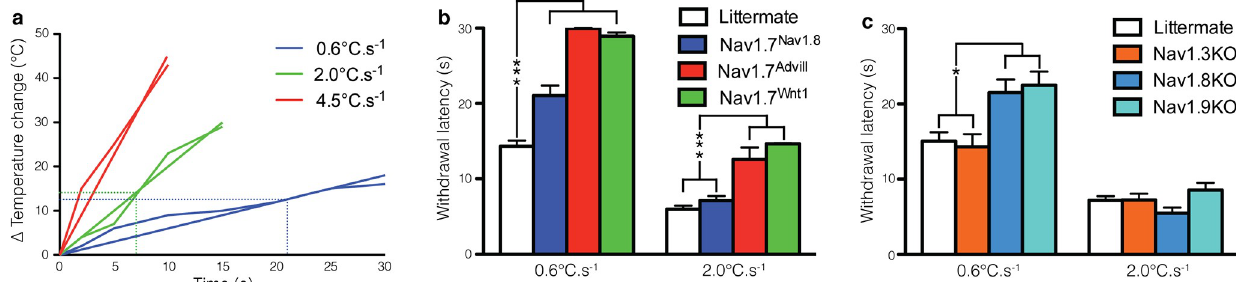
Fig 3. Comparison of different transgenic mice reveals stimulus-intensity specific responses to noxious thermal stimuli. Behavioural responses of different Nav1.7 tissue-specific knockouts to the Hargreaves test applied to the hindpaw. ( a ) Nav1.7 Nav1.8 mice (blue columns, n = 14), Nav1.7 Advill mice (red column, n = 7) and Nav1.7 Wnt1 mice (green column, n = 12) all show a behavioural deficit in response to the Hargreaves test at a heat ramp of 0.6˚C. s − 1 in comparison to littermate mice (white columns, n = 27), however ( b ) only Nav1.7 Advill and Nav1.7 Wnt1 mice show a behavioural deficit in response to the Hargreaves test at a heat ramp of 2.0˚C.s − 1 . ( c ) Nav1.8KO mice (light blue column, n = 6) and Nav1.9KO mice (turquoise column, n = 10) but not Nav1.3KO mice (orange column, n = 6) show a significantly increased withdrawal latency to the Hargreaves test at a heat ramp of 0.6˚C.s − 1 in comparison to littermate mice (white columns, n = 18), however this significant increase is lost the when the Hargreaves test is conducted using a heat ramp of 2.0˚C. s − 1 . Data analysed by two-way analysis of variance followed by a Bonferroni post-hoc test. Results are presented as mean ± S.E.M. � P < 0.05 and ��� P < 0.001 (individual